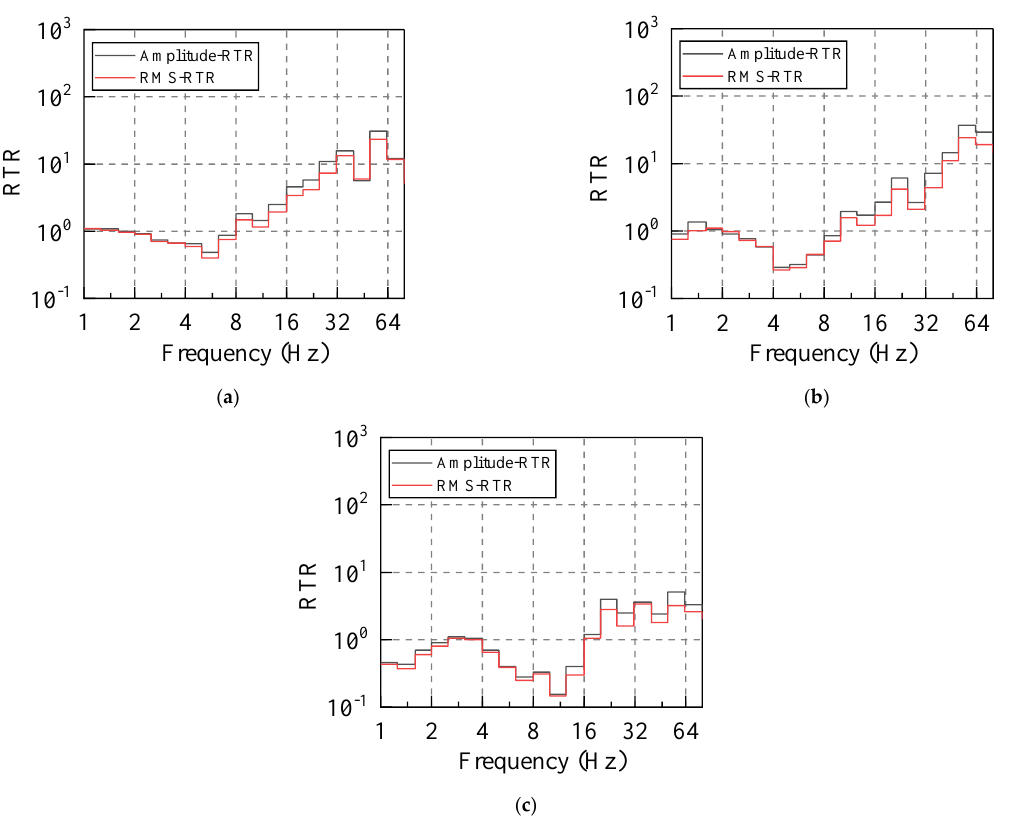
Figure 14. The measured RTR: ( a ) vertical direction; ( b ) east − west direction; and ( c ) south − west direction.